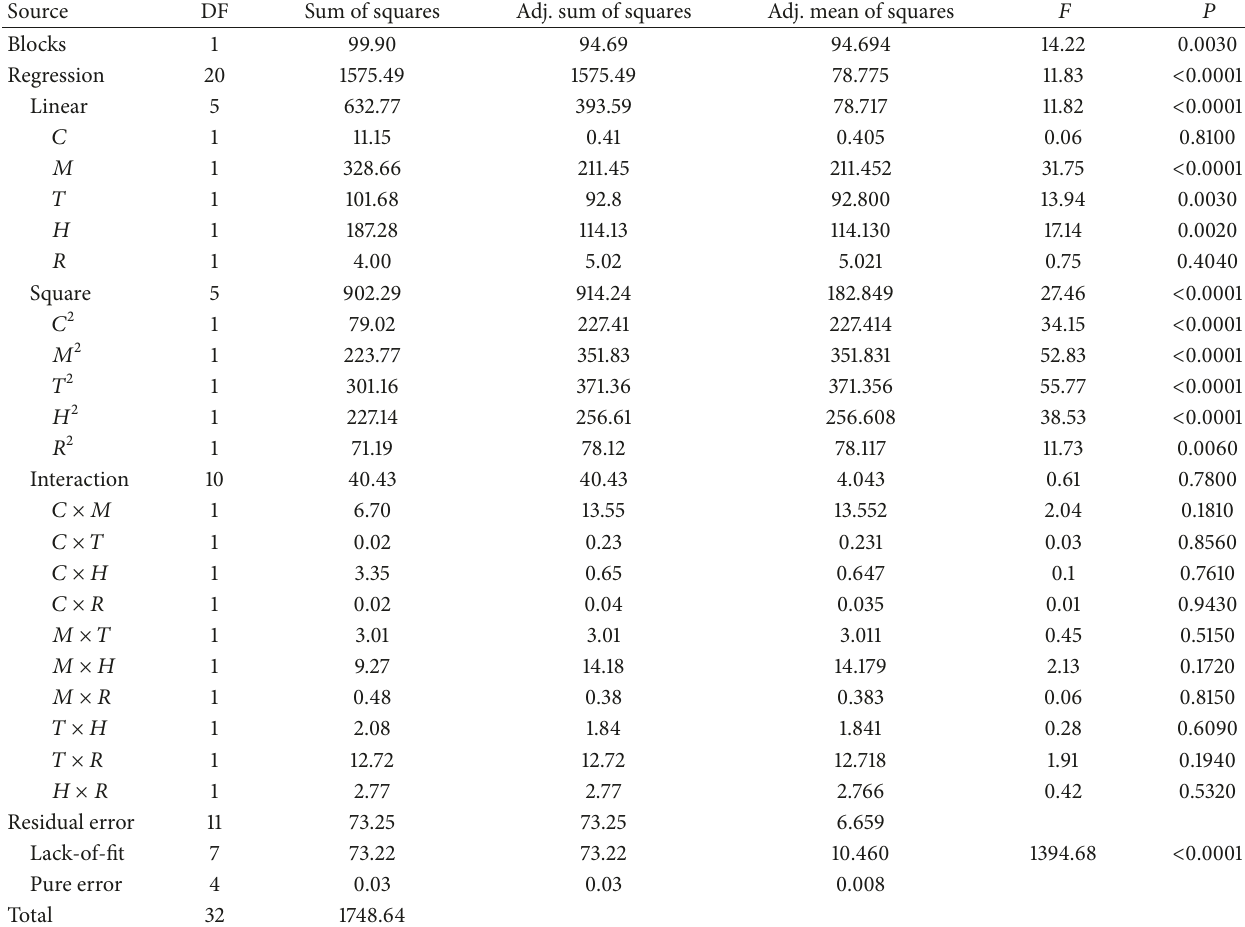
Table 4: Analysis of variance for optimal